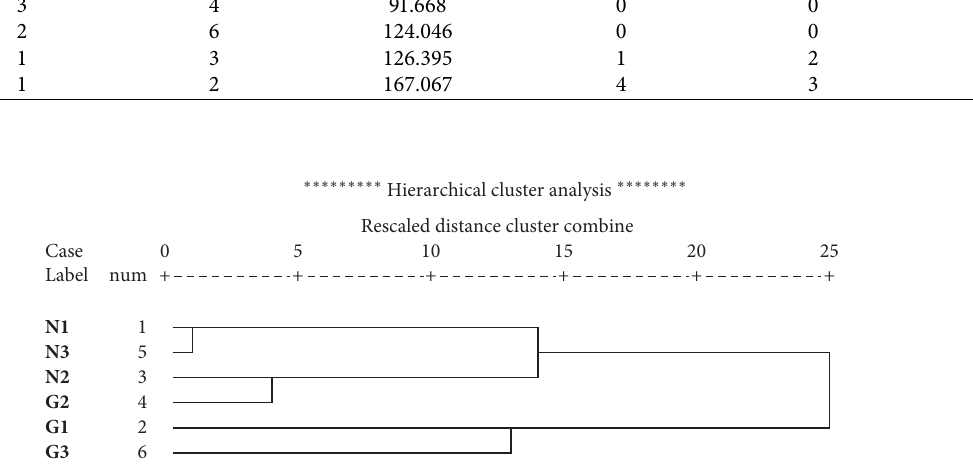
Figure 2: Dendrograms using complete linkage illustrating the average linkage between groups of complexes (hierarchical cluster analysis and rescaled distance cluster combine) for compounds detected by GC-MS in the six khat leaves extracts under